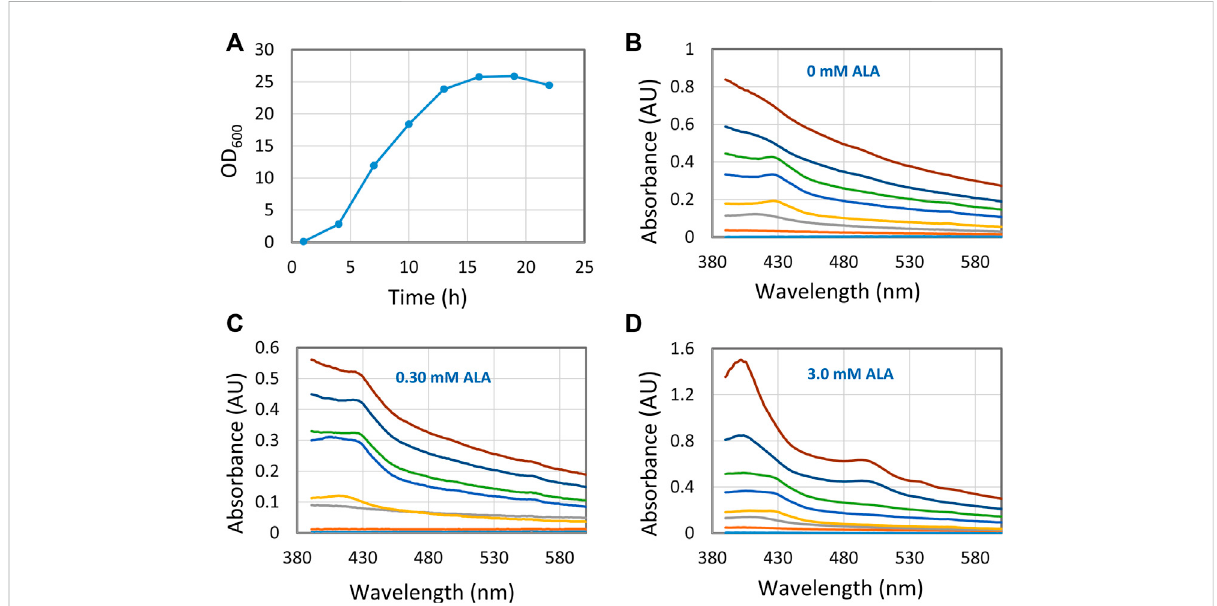
FIGURE 4 Hemoglobin/heme related compounds formed by E. coli at different 5-ALA (5-aminolevulinic acid) concentrations. (A) Growth curve with 0 mM 5-ALA. Essentially the same growth curve was observed for all experiments with different 5-ALA concentrations. (B – D) Spectra showing hemoglobin/heme related compounds formed at three 5-ALA concentrations. Samples were collected at 3 h intervals from 1 to 22 h. The 1-hour trace is close to the X-axis and the 22 h trace is at the top. For each occasion, 0.3 ml fermentation broth was sampled, the cells spun down, washed with Tris-HCl buffer, and suspended in 0.6 ml 30% (w/v)